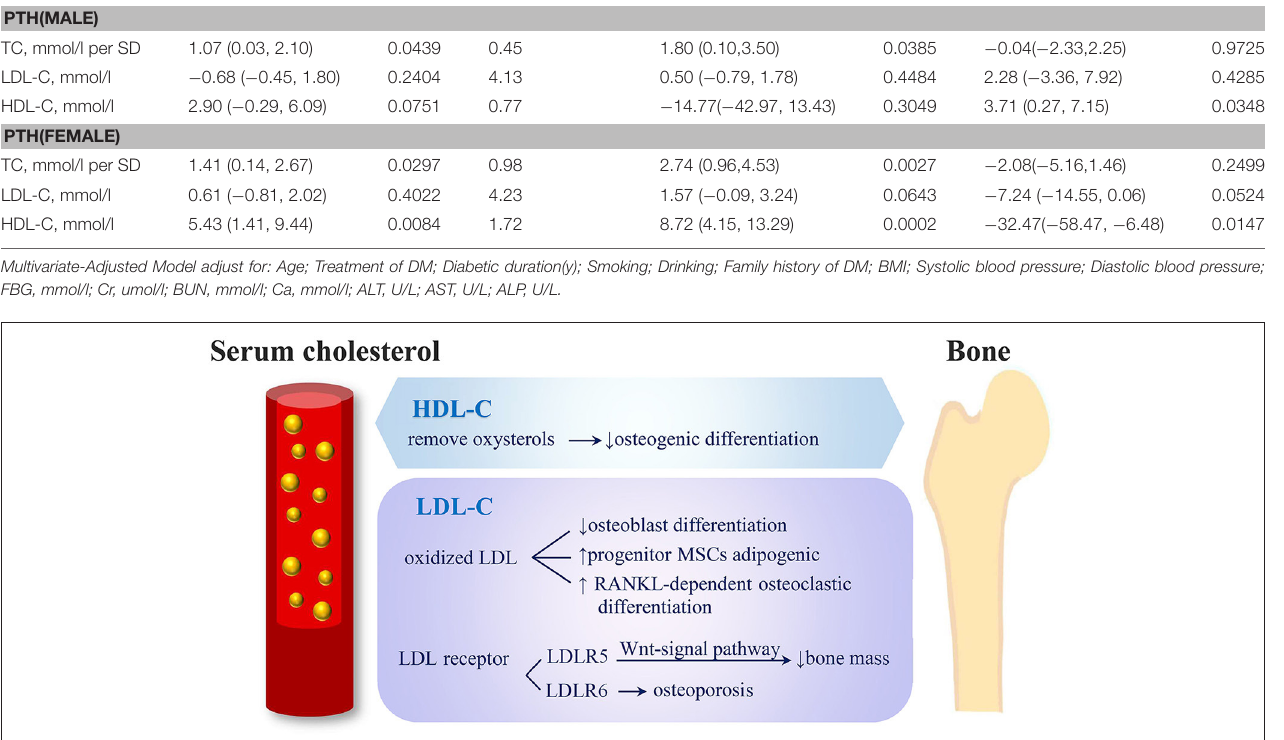
mice have indicated that hyperlipidemia more prominently blunted the anabolic action of PTH in the cortical bone than in the trabecular bone (51, 52); however, Kuipers